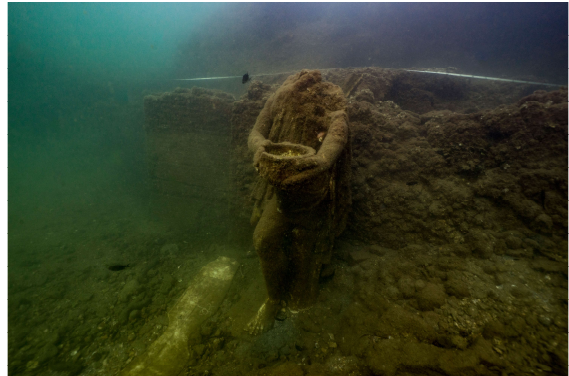
Figure 1. One of the replicas of the statues located in the Nymphaeum of Punta